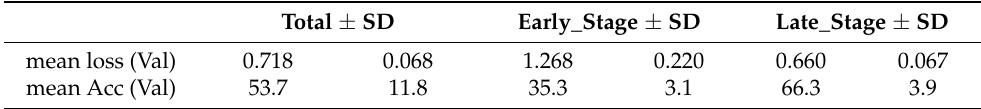
Table 4. mean loss(Val) and mean Acc(Val) in total, early_stage, and late_stage datasets with LR.